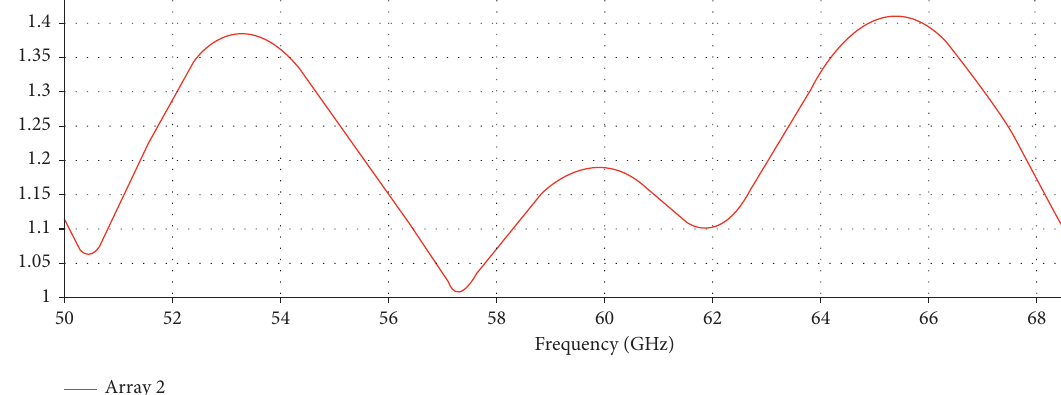
Figure 8: Free-space VSWR of Array 2.